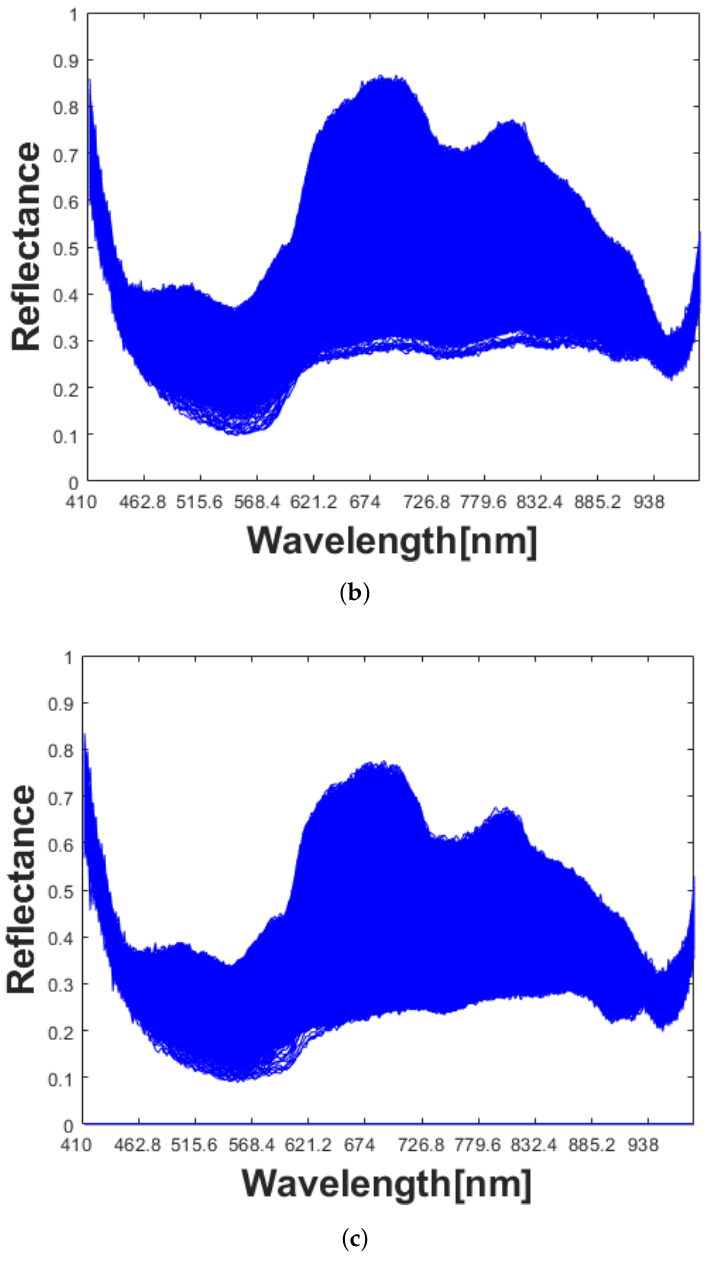
Figure 6. ( a ) Plot of HSI-curves from acquisition number one from frozen fish at day 0. ( b ) Plot of HSI-curves from acquisition number two from frozen fish at day 4. ( c ) Plot of HSI-curves from acquisition number four from frozen fish at day